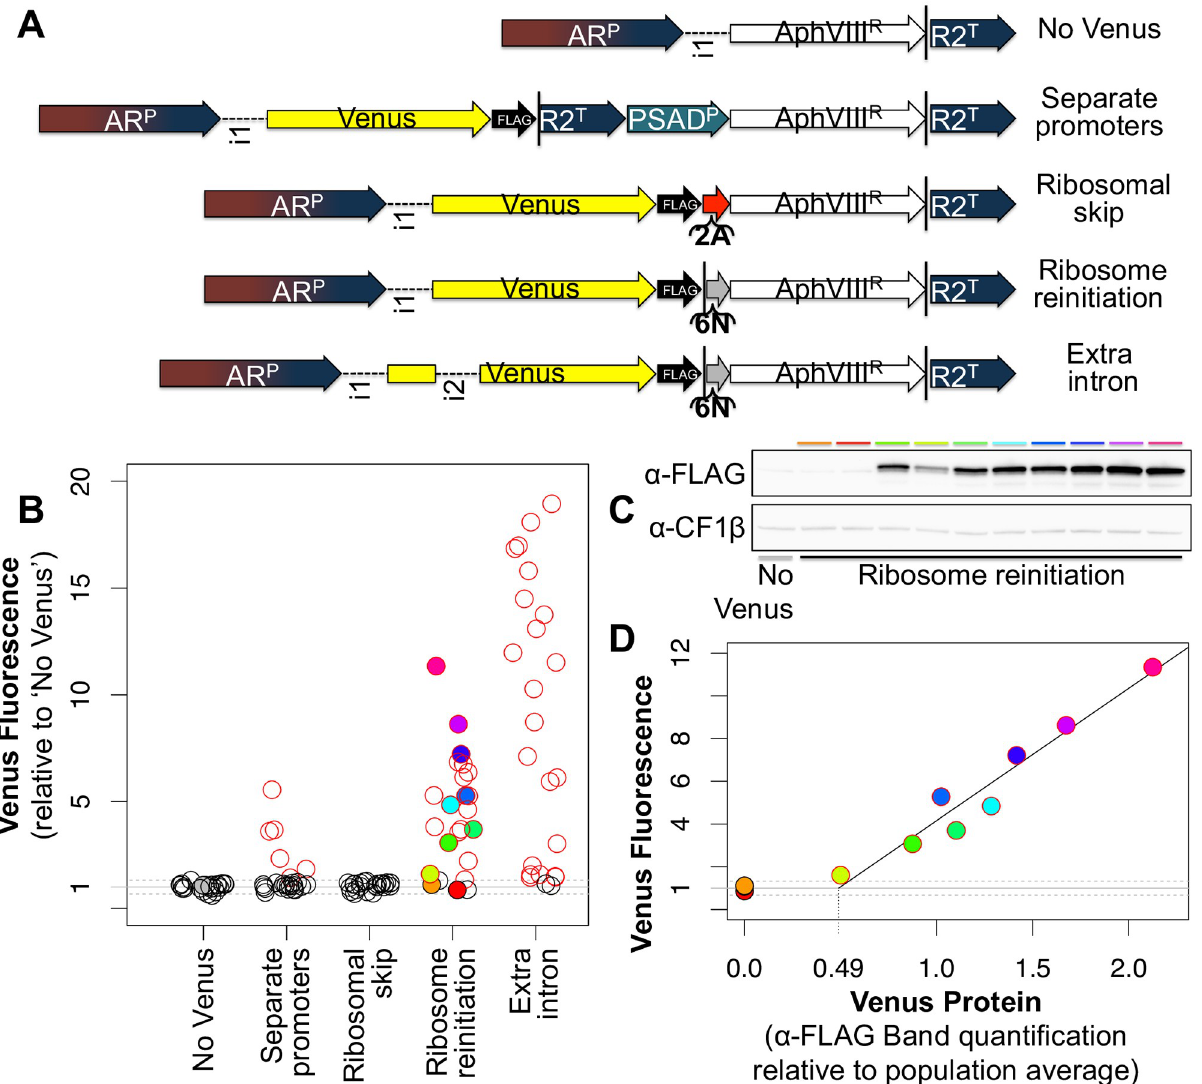
Fig 1. A high fraction of transformants with high transgene expression can be achieved through ribosome reinitiation combined with multiple introns. (A) Chlamydomonas expression constructs are composed of the following elements—promoters: chimeric HSP70-RBCS2 (AR P ), PSAD (PSAD P ); terminator: RBCS2 (R2 T ); introns: RBCS2 1 (i1) and 2 (i2); protein coding genes: Paromomycin resistance (AphVIII R ), Venus fluorescent reporter (Venus); tag: triple-FLAG (FLAG); bicistronic expression elements: Viral 2A sequence (2A), the six nucleotides TAG CAT (6N); STOP codons are indicated by black vertical lines (|). (B) For each construct, fluorescence of 24 independent transformant lines is shown. Venus fluorescence intensities were normalized to autofluorescence as measured in ‘No Venus’ transformants; red circles indicate transformants that lie outside the 95% confidence interval for ‘No Venus’ (indicated by dashed lines). Filled circles denote those transformants that were analysed by Western blot (C) as indicated by the colour code. Whole cell protein extracts normalized to 2 μ g chlorophyll were loaded in each lane. Antibodies against the FLAG-tag at the Venus C-terminus ( α -FLAG) and, as loading control, chloroplast ATP-synthase subunit CF1 β ( α -CF1 β ) were used. Blots were cropped for clarity, raw images are provided in S1 Raw images. (D) Venus fluorescence levels from (B) are plotted against Venus protein levels, quantified from (C) as Western band intensity relative to the population average. A linear regression line is drawn based on transformants with detectable Venus fluorescence and protein levels (R 2 = 0.94). DNA sequences of construct elements and the numeric data underlying the graphs are provided in S1 Data. https://doi.org/10.1371/journal.pone.0237405.g001 Venus-FLAG Western band intensity 0.49 times as high as the population average (or 0.54 to reach the 95% confidence interval). In other words, Venus fluorescence is indistinguishable from autofluorescence in ‘ribosome reinitiation’ transformants expressing Venus-FLAG up to a level that is ~50% of the population average.